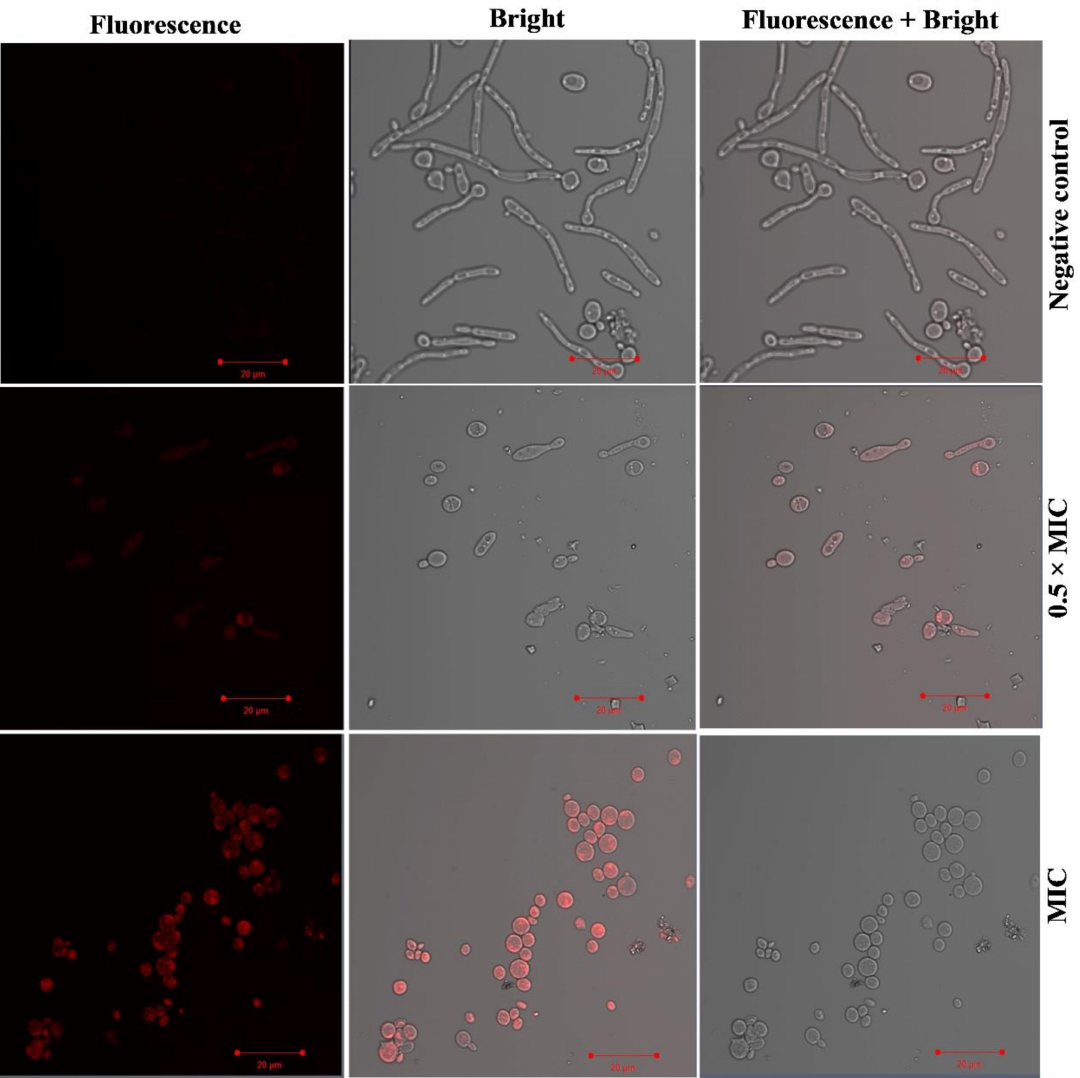
Figure 6. Intracellular accumulation of R6G in FLZ-resistant Candida cells. Fluorescence microscopy of R6G-stained FLZ-resistant Candida 5112. In the negative control, there was no accumulation of the dye after addition of glucose, whereas exposure to 0.5 × MIC (0.78 µ g/mL) and MIC (1.56 µ g/mL) of Ag-Ni NPs resulted in accumulation of R6G inside the C. albicans 5112